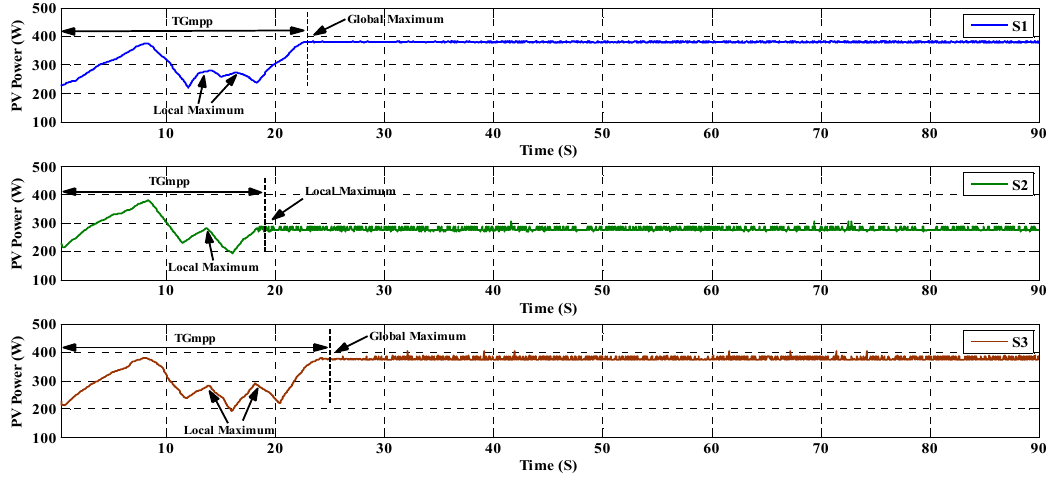
Figure 21. PV output power for the scenario of Figure 20.